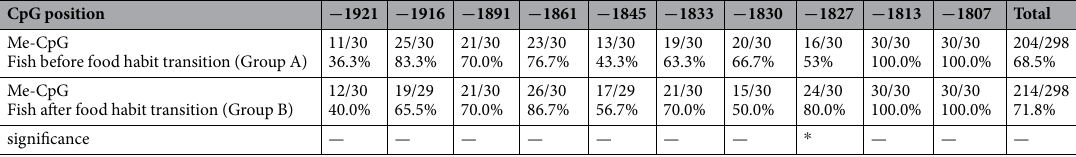
— — — — — — — — — — — — — — Table 5. Methylation status of each CpG in CpG island 2 of the T1R1 gene in grass carp before or after the food habit transition. * P < 0.05 — P > 0.05.